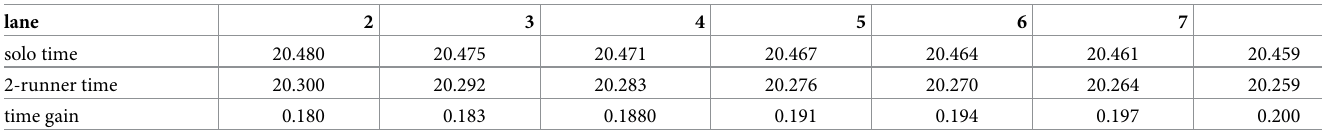
Table 4. Athlete A 1 at lane k running against himself at lane k − 1. Interaction γ = 0.04 with inhibition η = 20 m . Race time and gain with respect to solo race time.